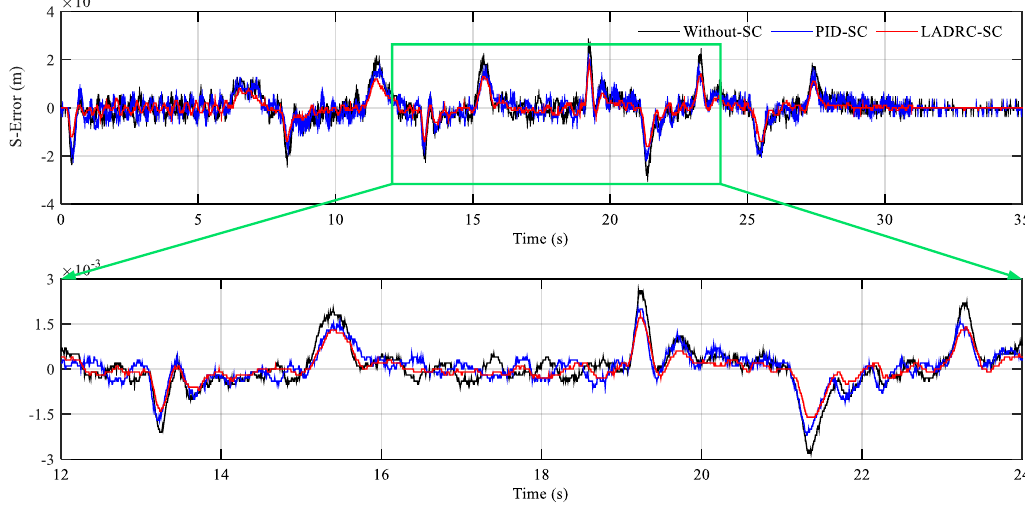
Figure 14. Synchronization error comparison results of the slope signal.